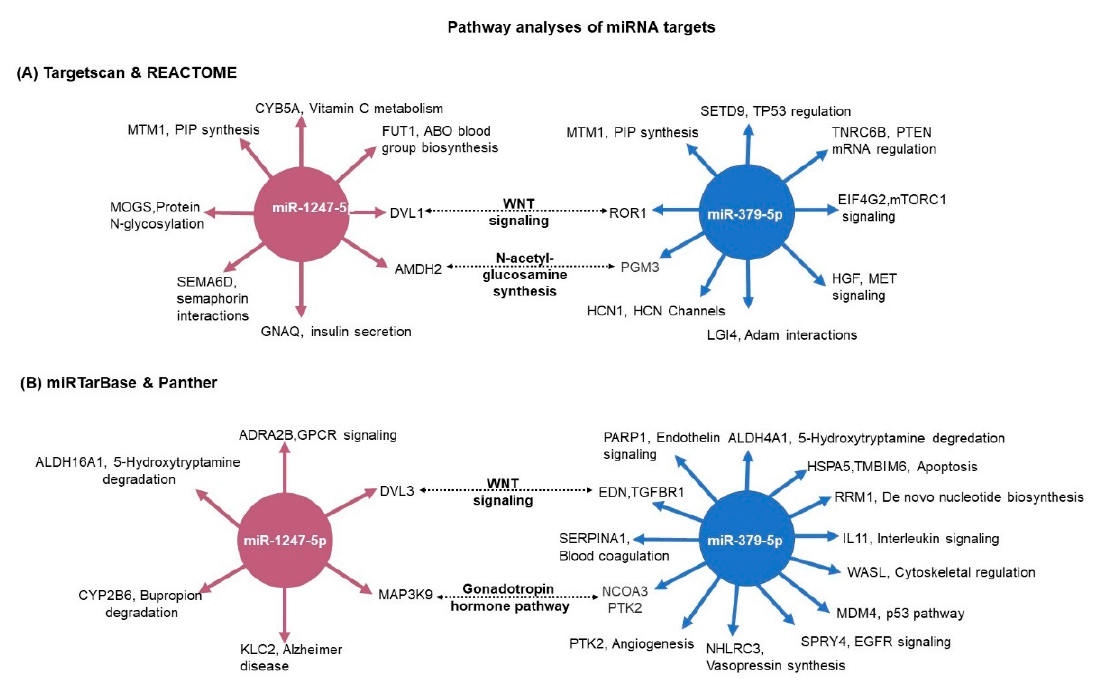
Figure 9. Pathway analyses of miRNA target genes. ( A ) The predicted targets were matched with the RNA-seq expression data. For miR-1247-5p, CPA vs. controls expression data; and for miR-379-5p, PBMAH vs. controls expression data. The significantly expressed target genes were then subjected to pathway analyses by Reactome. The significantly enriched pathway networks ( p < 0.05) and their related genes are given. ( B ) The experimentally validated target genes from miRTarBase were analyzed for their role in pathways by the Panther database. The target genes and their related pathways are given. The commonly represented pathways are marked in bold.